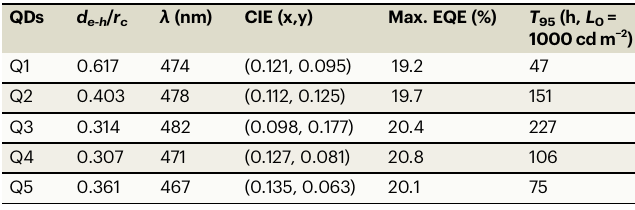
Table 1 | Electroluminescence performance of blue QDs with different surface-bulk coupling